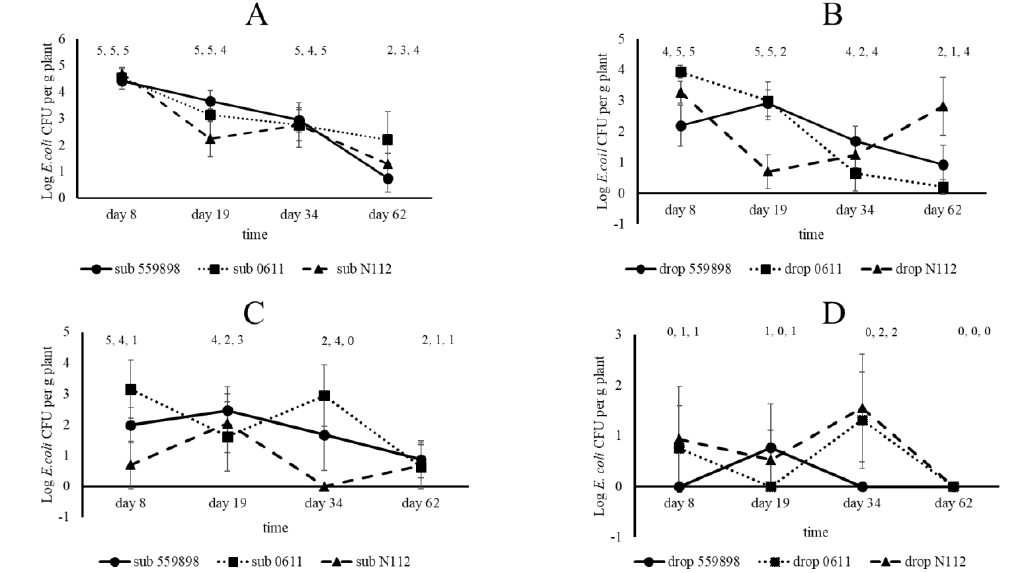
Figure 3. Colonization of roots ( A , B ) and epicotyl / stem base ( C , D ) of pea plants grown from seeds treated with E. coli strains 55989, 0611, or N112, either via seed submergence ( A , C ) or drop inoculation ( B , D ). Symbols: circle, strain 55989; square, strain 0611; triangle, strain N112. Numbers above symbols indicate the number of plants found to be positive for the presence of introduced E. coli strains, of five replicate plants.